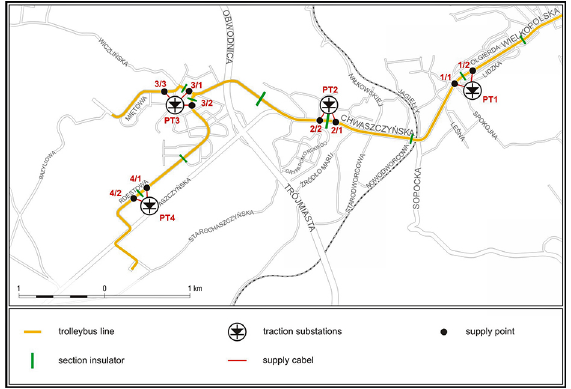
Fig. 3. Example of decentralized supply system, one-side supply